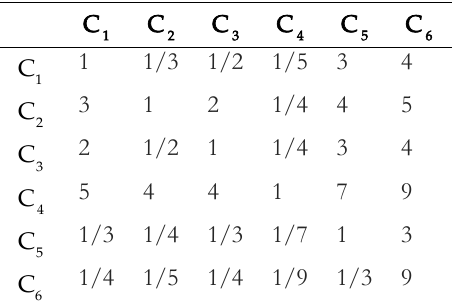
Table 12. Pairwise comparisons of the